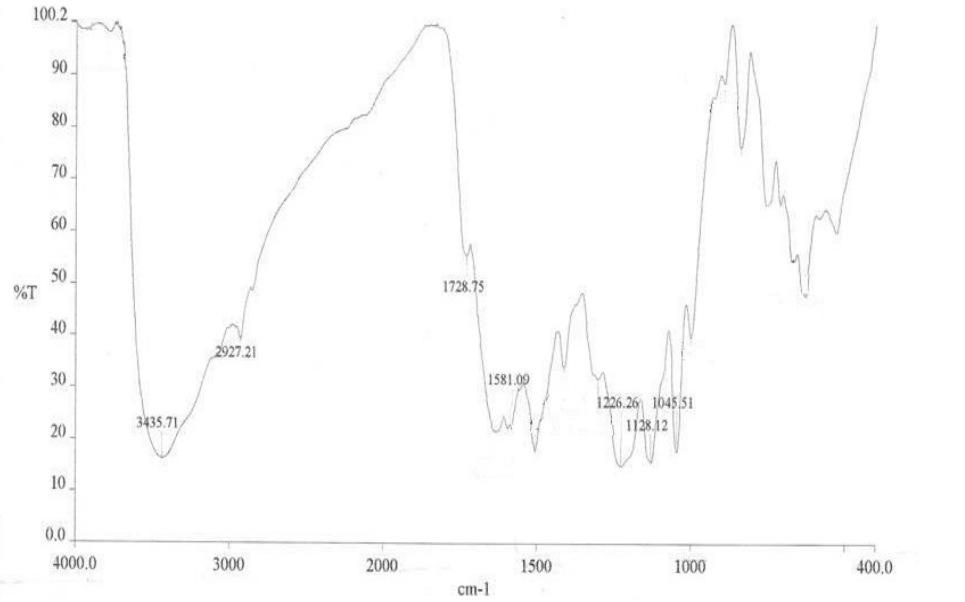
Figure 3. Infrared Spectra of final compound (C)